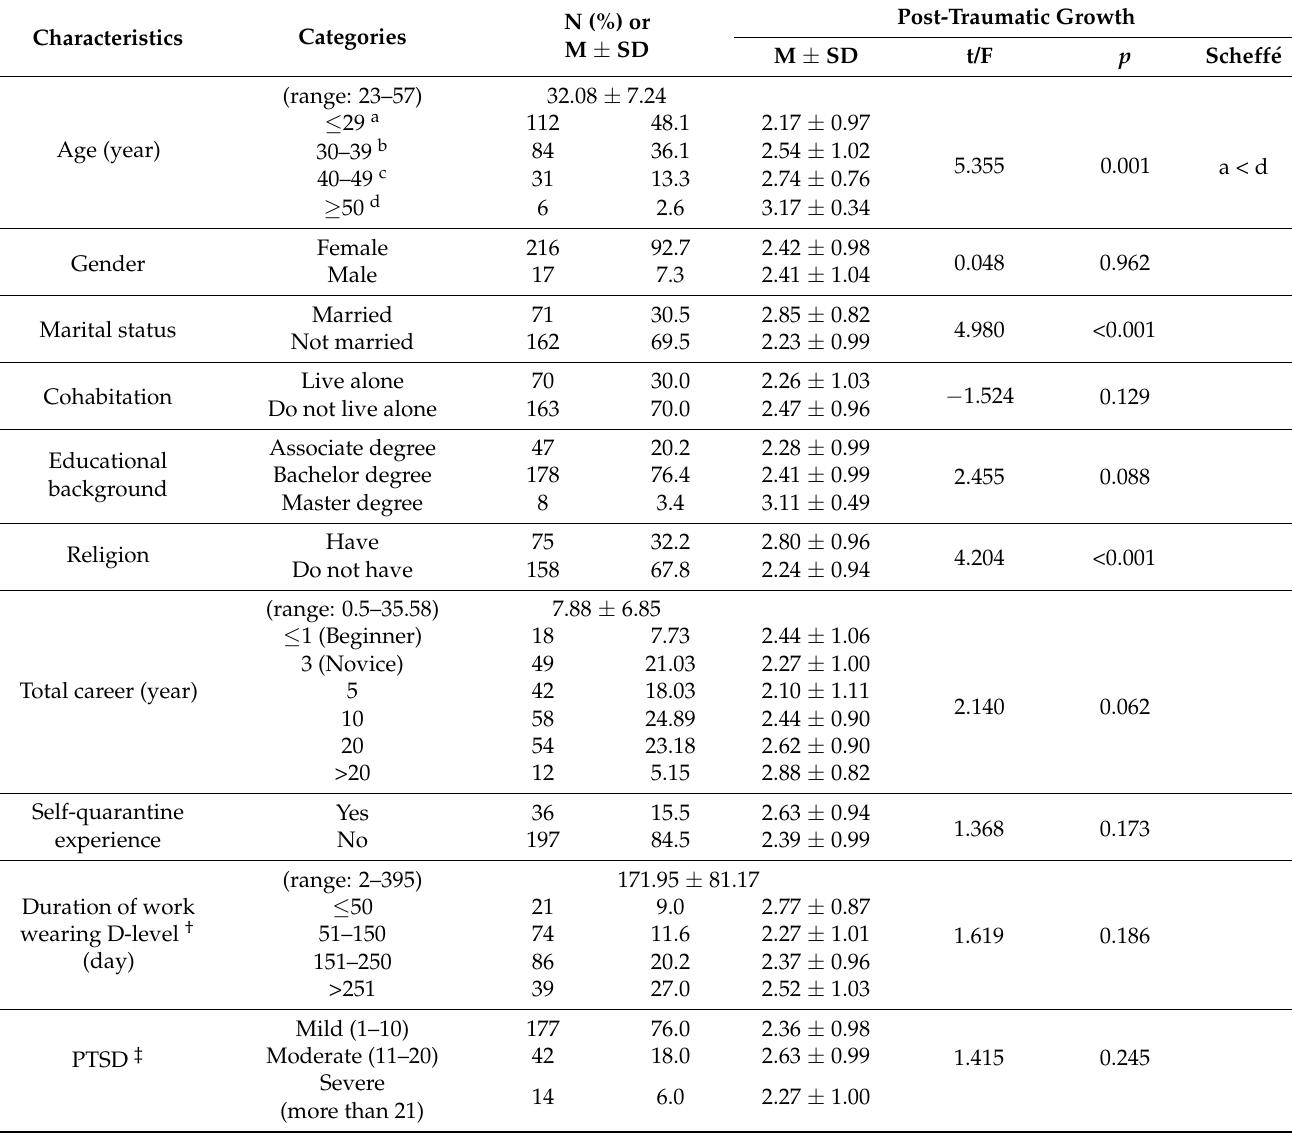
Table 1. Differences in Post-Traumatic Growth according to Participants’ Characteristics (N =